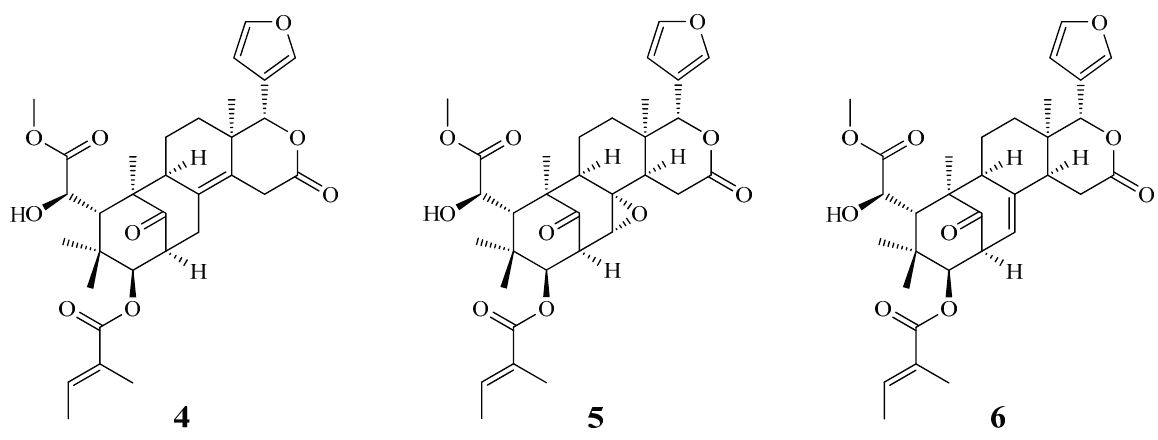
Figure 1. The chemical structures of new compound 1 and known compounds 2 – 6 isolated from S. macrophylla